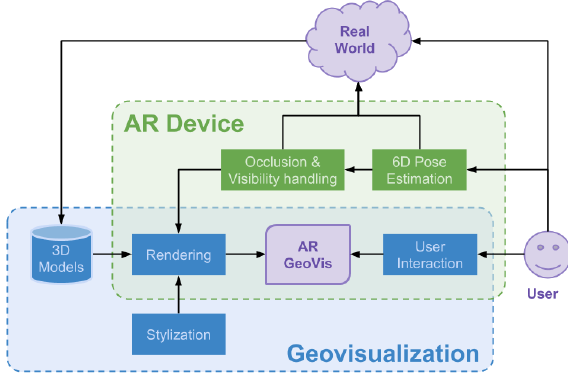
Figure 3. Geovisualization and AR combined pipelines.